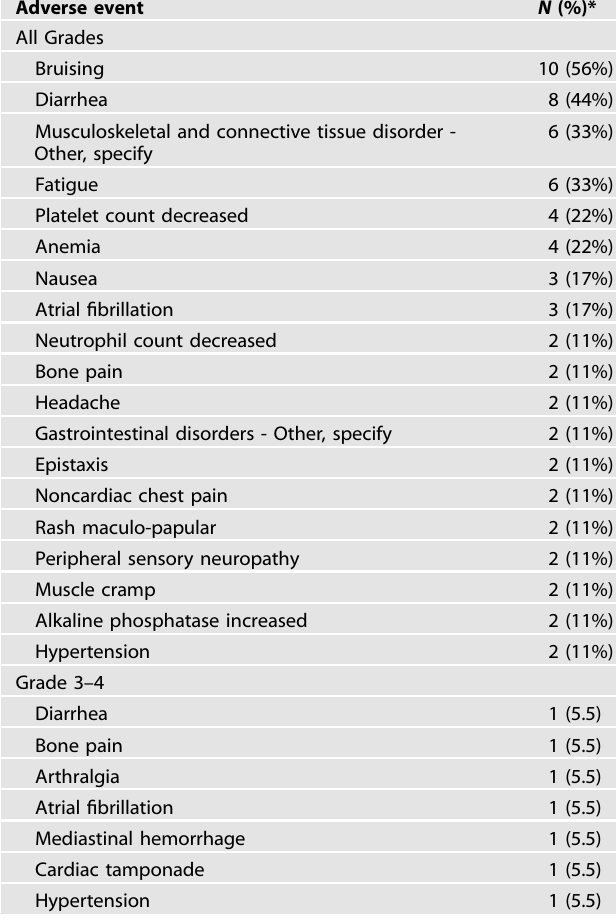
Table 3. Eight patients with MCL enrolled on study, four patients had